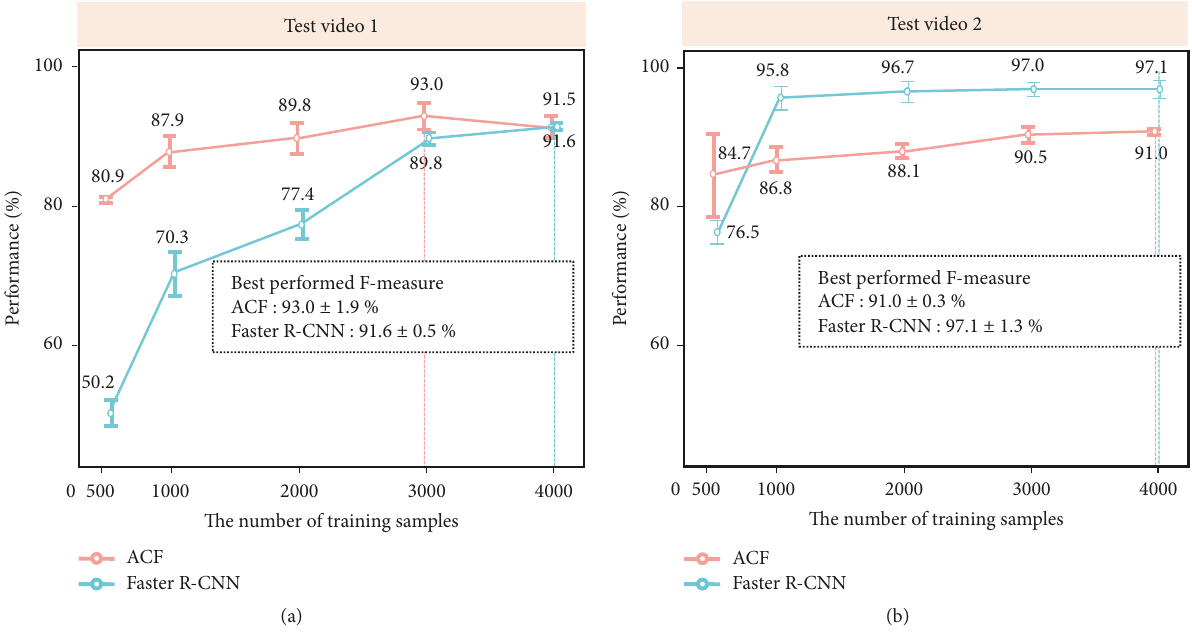
Figure 5: Variation in detection performance with the number of training samples. (a) Test-video 1 shows the best F-measure of 93.0% with a standard deviation of 1.9% using ACF with 3,000 samples, and (b) test-video 2 shows the best F-measure of 97.1% with a 1.3% standard deviation using Faster R-CNN with 4,000